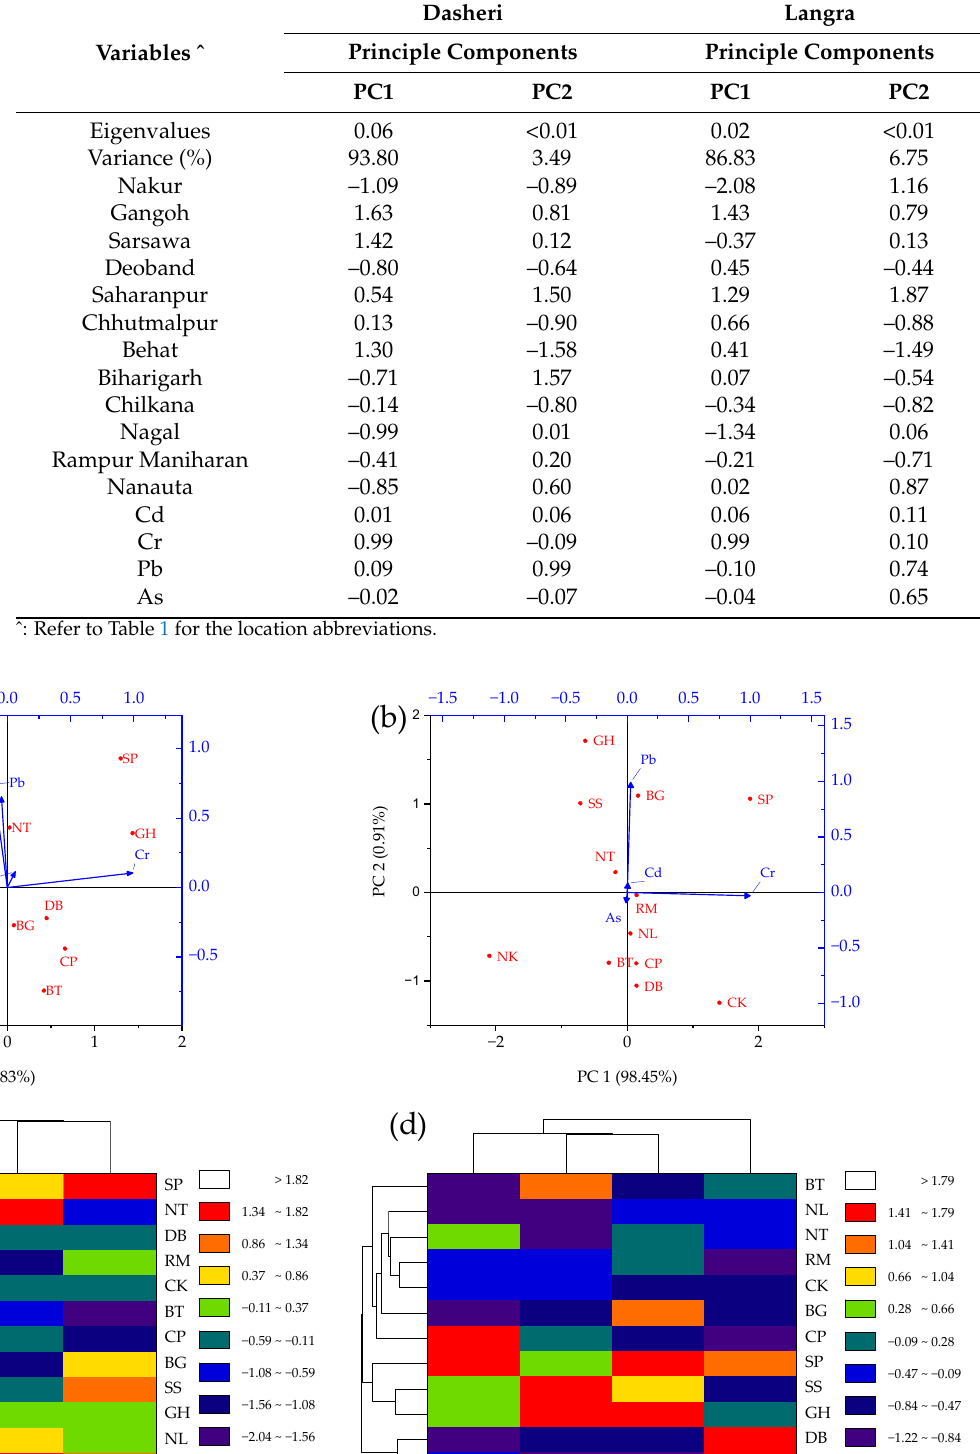
Table 3. PCA results of heavy metal contents in two mango fruit ( M. indica ) variety samples collected from Saharanpur district, Uttar Pradesh, India.